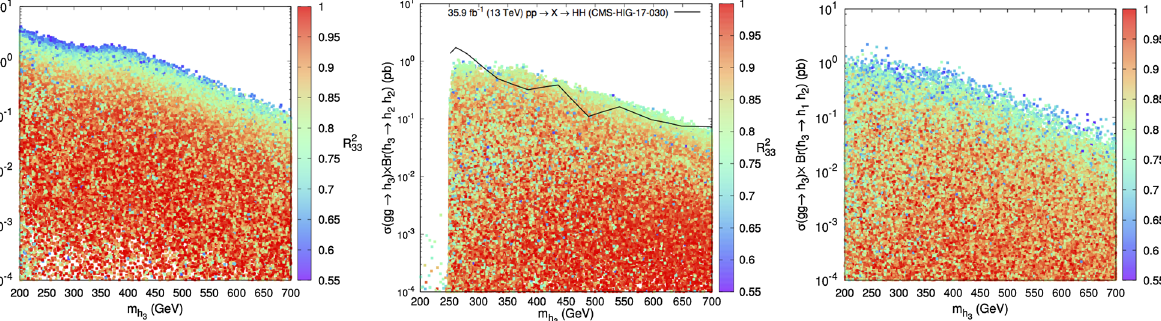
Fig. 13 σ( pp → h 3 ) × Br ( h 3 → h 2 h 2 ) (left panel), σ( pp → h 3 ) × Solid line is the observed 95% CL exclusion limits on the production Br ( h 3 → h 1 h 1 ) (middle panel) and σ( pp → h 3 ) × Br ( h 3 → h 1 h 2 ) of a narrow width spin zero resonance decaying into a pair of Higgs ( GeV ) and R 2 (right panel) as a function of m h bosons in N2HDM type-I. 33 3